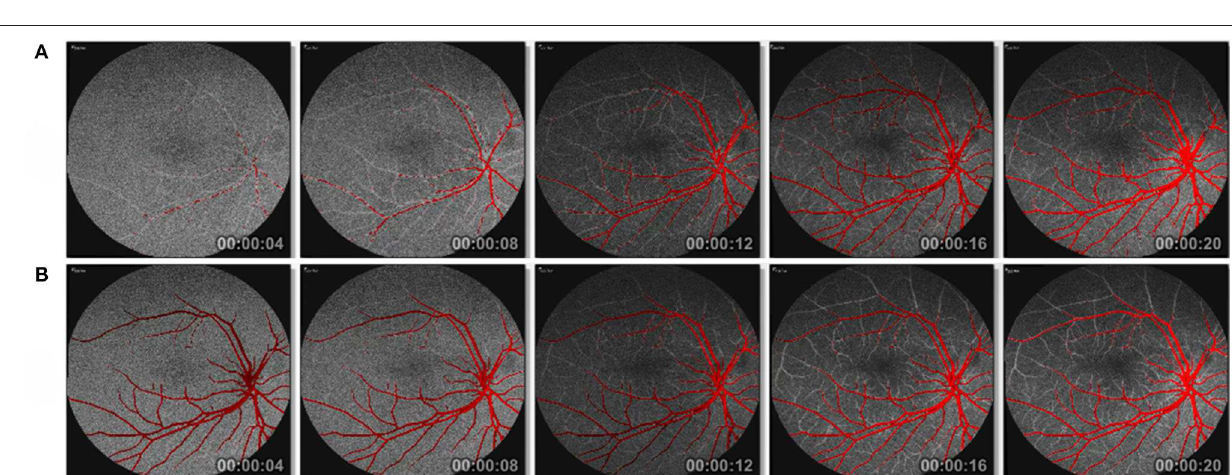
veins, we see a complete picture. To get a better understanding of the blood flow dynamics, we perform a second experiment. Instead of using the corresponding masks for each frame,